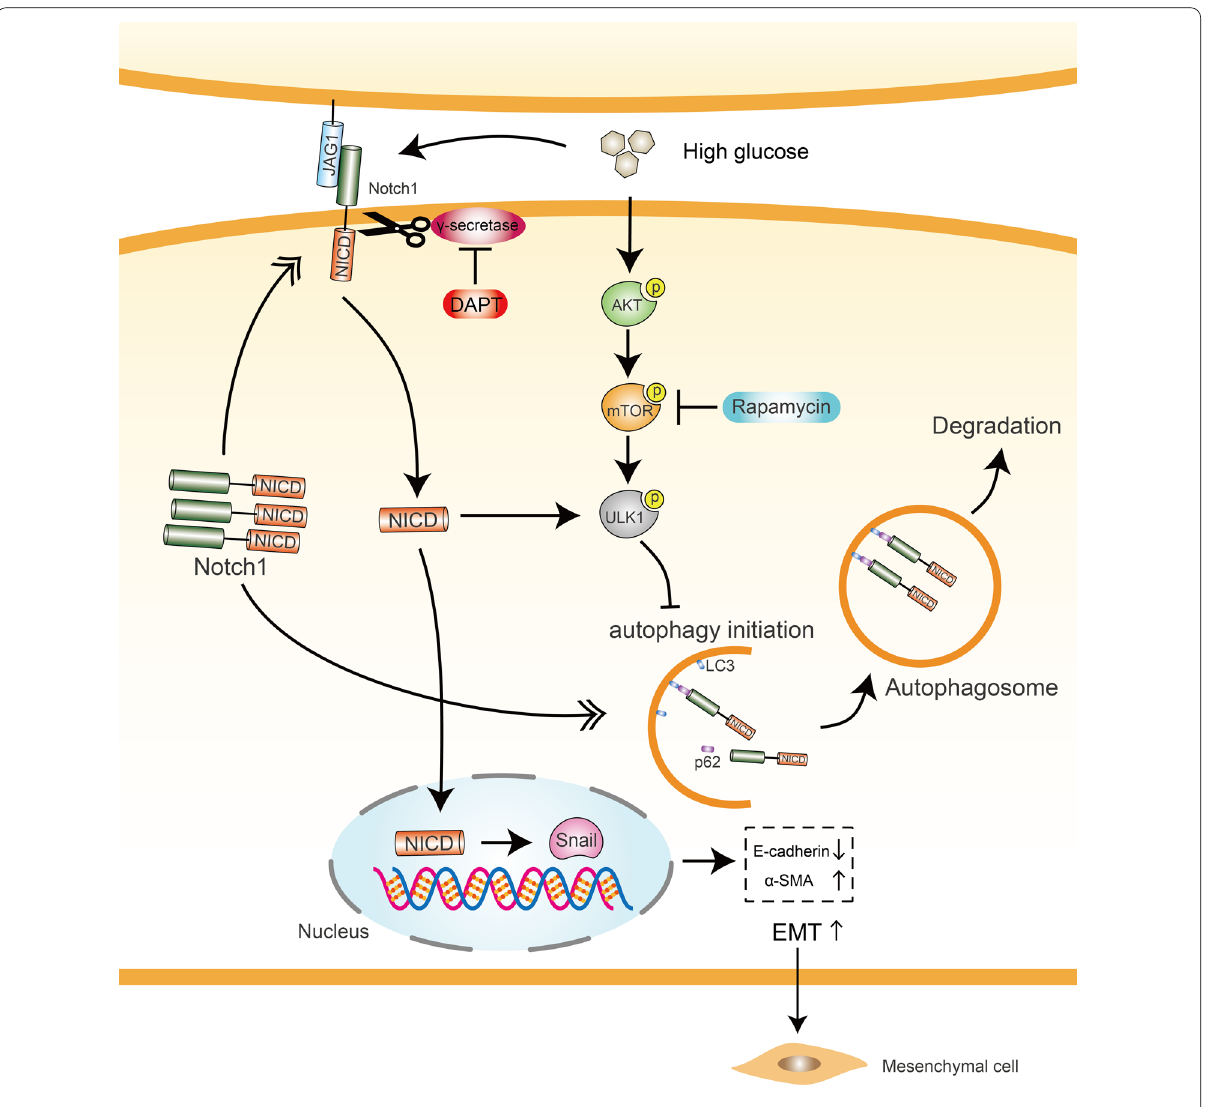
Fig. 8 Schematic representation of the mechanism of mutual regulation between autophagy and the EMT in LECs stimulated with high glucose